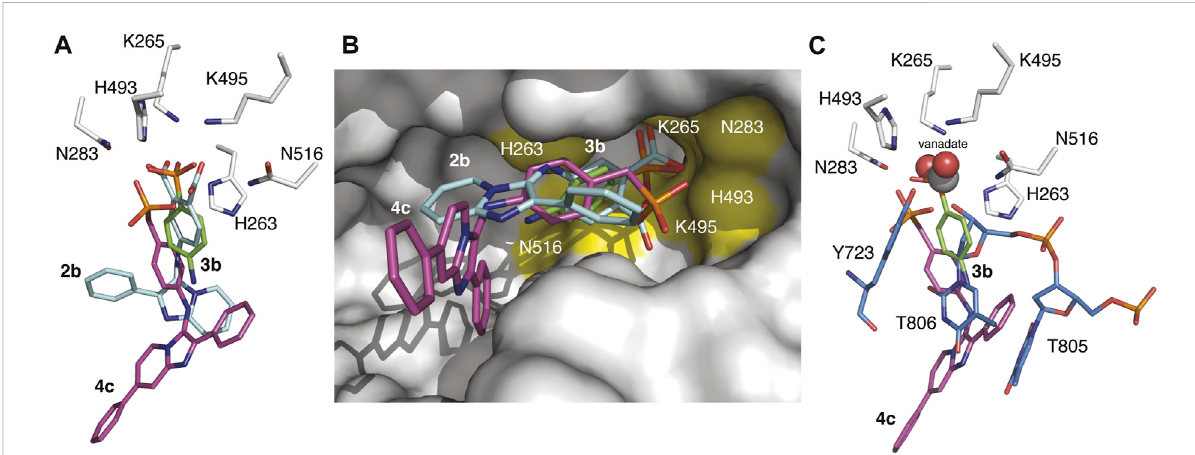
FIGURE 6 OverlaidstructuresofTDP1withboundsmallmoleculesandsubstrate. (A) ActivesitestructuresofTDP1boundtocompound 2b (carbonatoms in cyan, PDB code: 6W7K) and 3b (carbon atoms in green, PDB code: 7UFZ) superimposed onto the structure of TDP1 bound to compound 4c (carbon atoms in magenta, PDB code: 7UFY). (B) Surface representation of TDP1 (gray) showing the orientation of compounds 2b , 3b , and 4c in the active site groove. The catalytic HKN residues are highlighted in yellow. (C) Active site structures of TDP1 bound to compound 3b and of TDP1 bound to vanadate, ssDNA substrate, and a TOP1-derived peptide (carbon atoms in light blue, PDB code: 1NOP) superimposed onto the coordinates of TDP1 bound to compound 4c